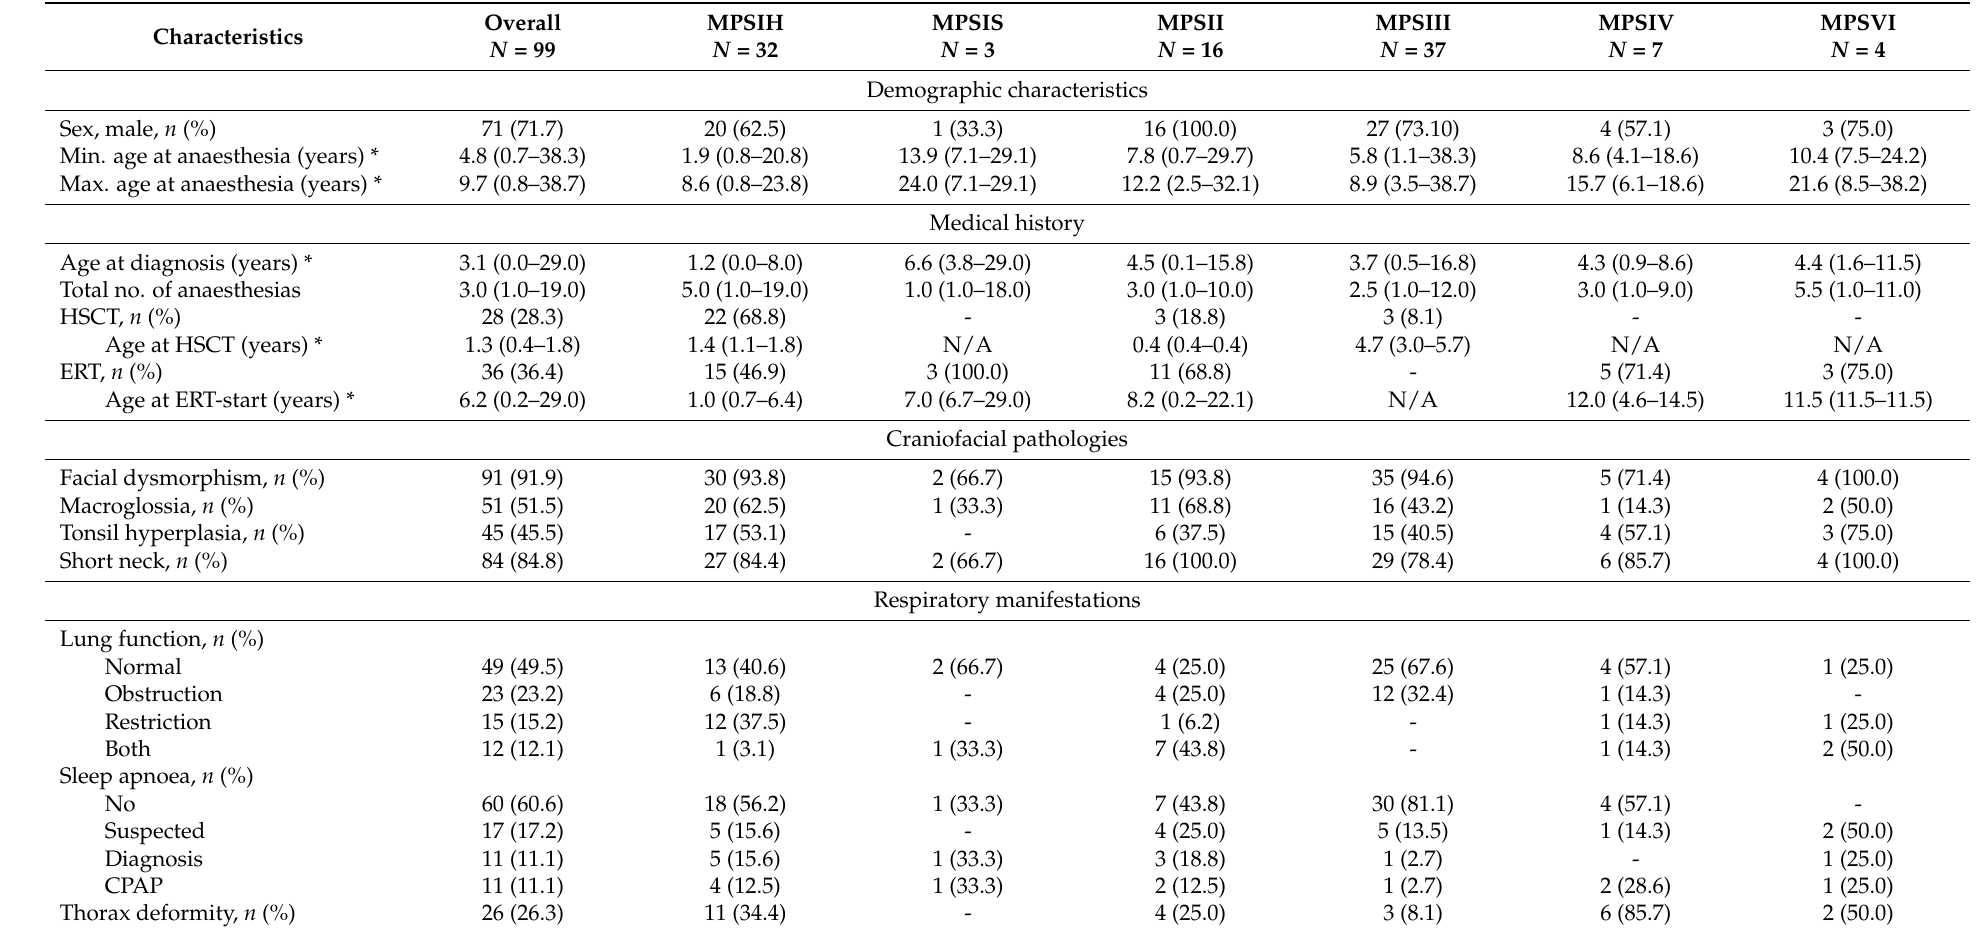
Table 1. Patient characteristics stratified by MPS disease